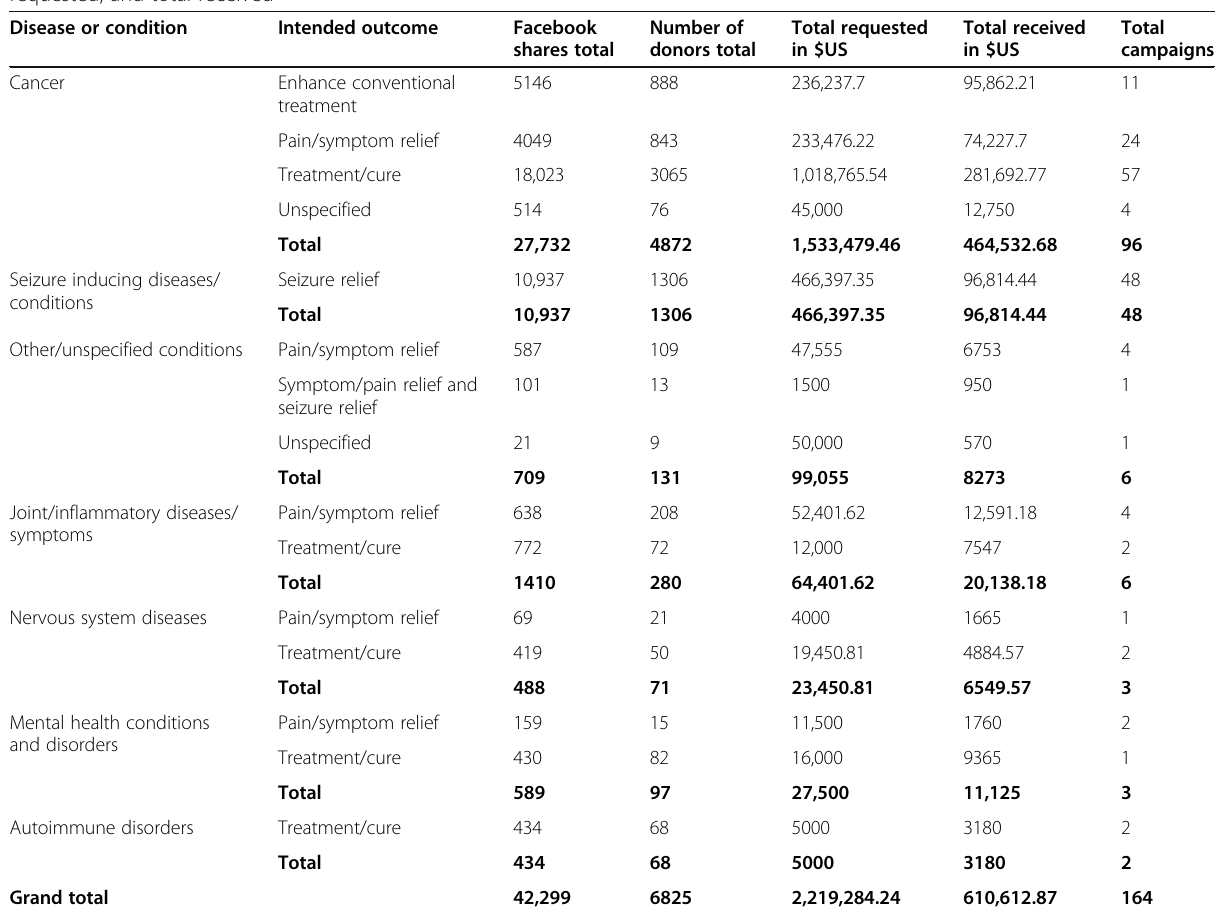
Table 1 Disease or condition proposed for CBD usage on GoFundMe.com by intended outcome, Facebook shares, donors, total requested, and total received Disease or